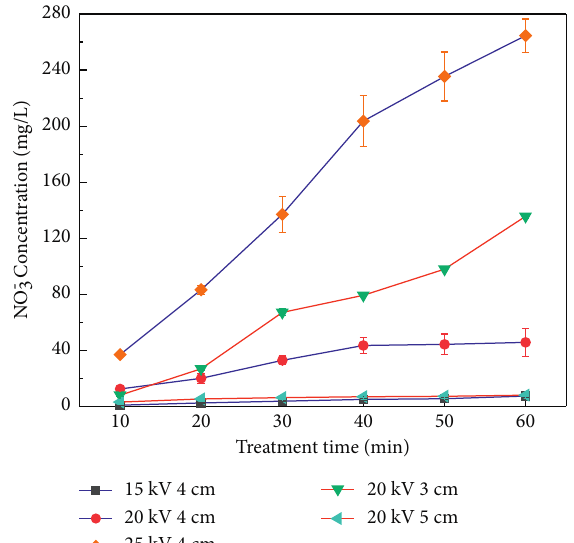
Figure 14: NO − concentrations at voltages of 15, 20, and 25 kV and the needle-dielectric plate distance of 4cm and the needle-dielectric 3 plate distance of 3, 4, and 5cm and voltage of 20kV.